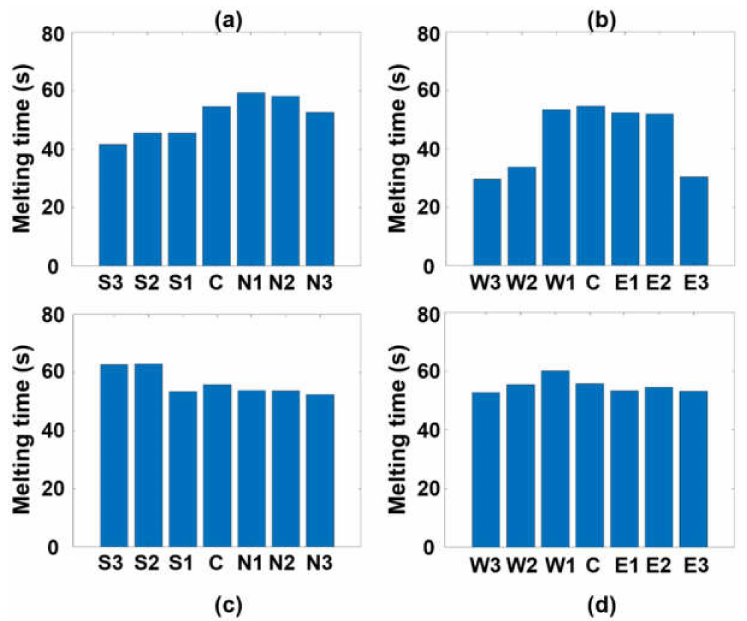
Figure 10. Melting times of the nickel particle. ( a ) Additions in the N–S axis at a level of 16 tons. ( b ) Additions in the E–W axis at a level of 16 tons. ( c ) Additions in the N–S axis at a level of 30 tons. ( d ) Additions in the E–W axis at a level of 30 tons. Steel superheat is 15 K.